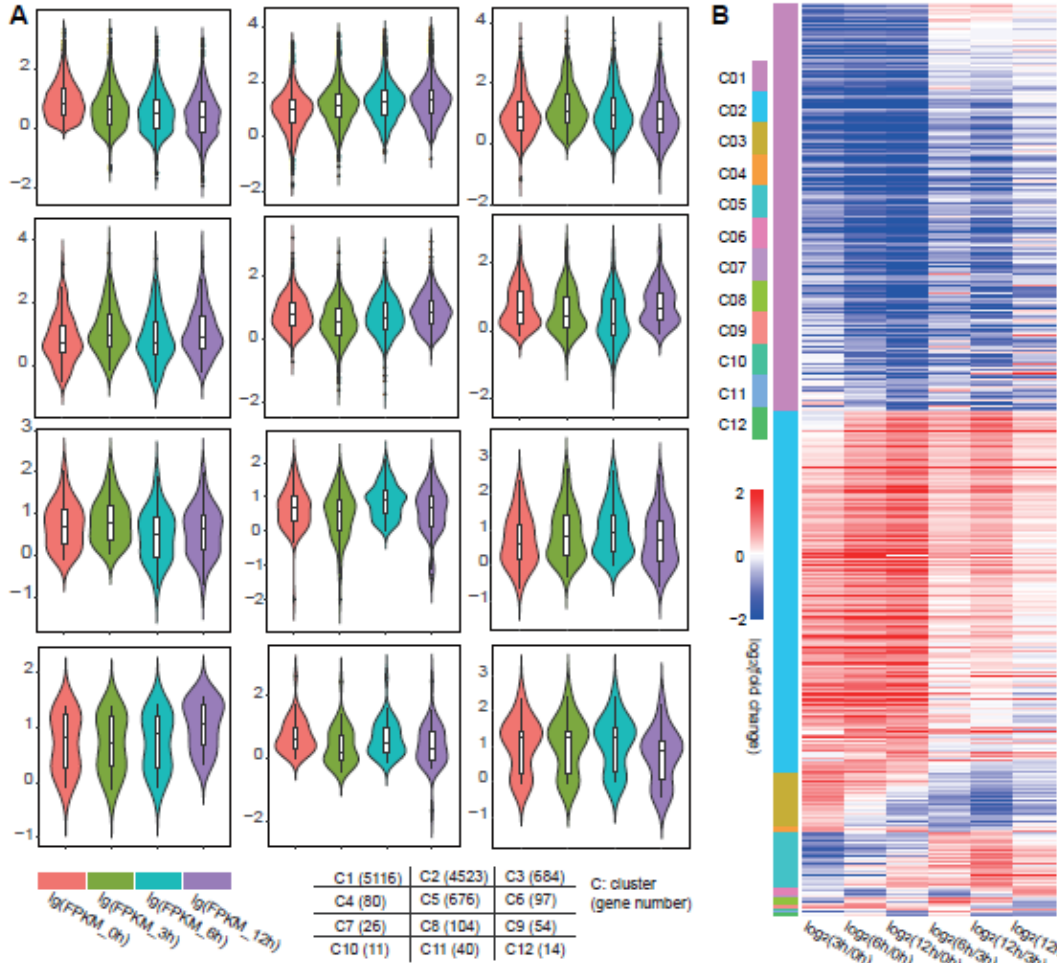
Figure 2. Total DEGs among the four time points were separated into 12 clusters by dynamic regulation pattern. ( A ) On the basis of FPKM for DEGs in each time point, there were 12 clusters in the time series response. The Violin diagram shows the expression level of genes in each group. The FPKM values were converted to lg forms to reduce the di ff erence between outliers. Di ff erent colors represent four processing time points, which are 0, 3, 6, and 12 h from left to right. The tags and number of genes in each group are written in the grid graph at the bottom. ( B ) The di ff erential expression pattern between two time points are shown in the Heatmap. The color column at the left shows the 12 clusters. The red–blue Heatmap contains the DEGs between 3 and 0 h, DEGs between 6 and 0 h, DEGs between 12 and 0 h, DEGs between 6 and 3 h, DEGs between 12 and 3 h, and DEGs between 12 and 6 h.